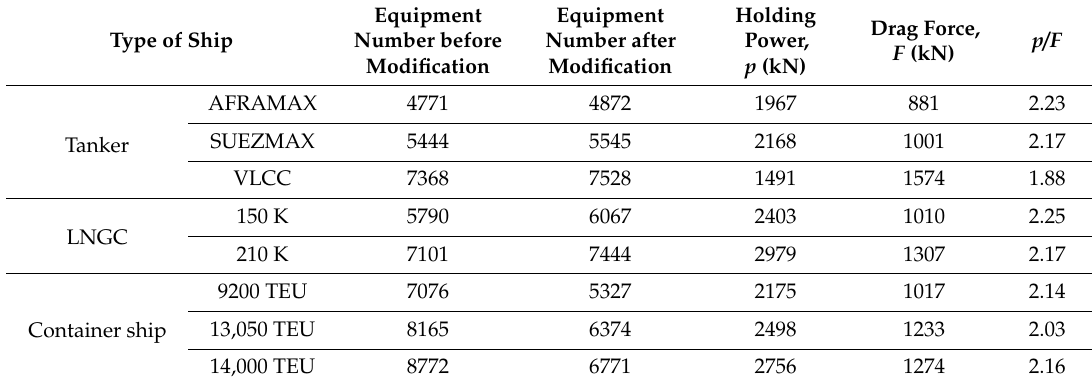
Table 6. Calculation of equipment number using modified coe ffi